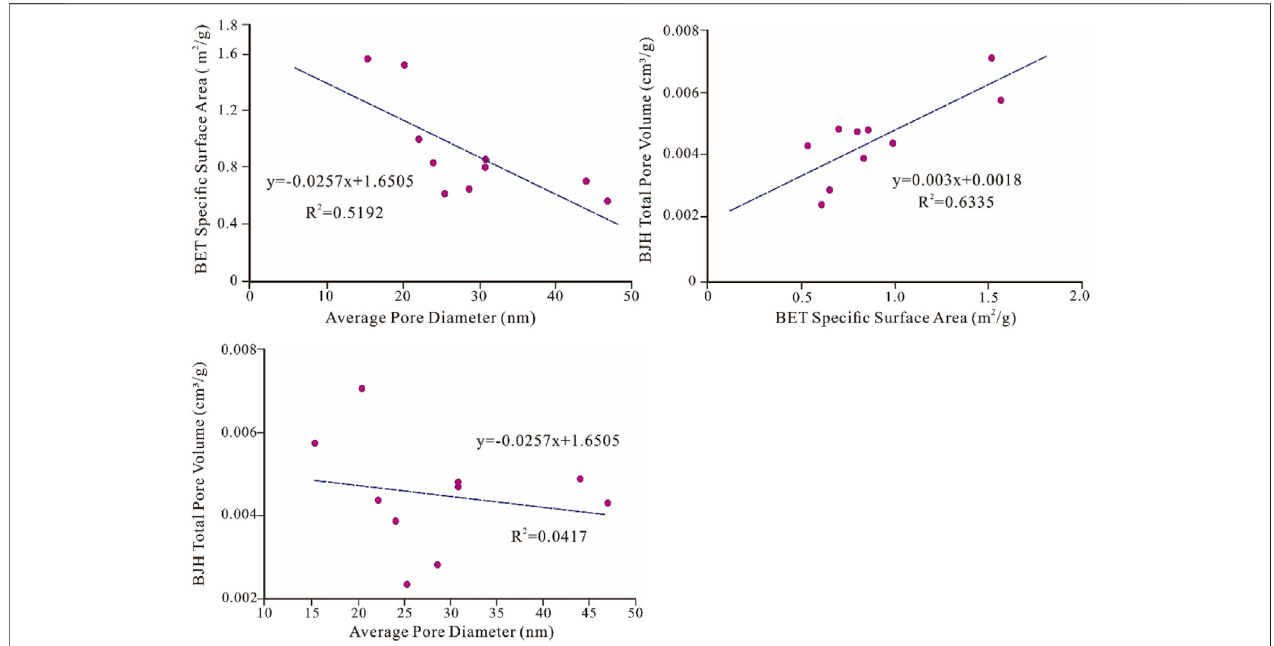
FIGURE 8 | Scatter diagrams showing relationships between different pore structure parameters of all shale samples.